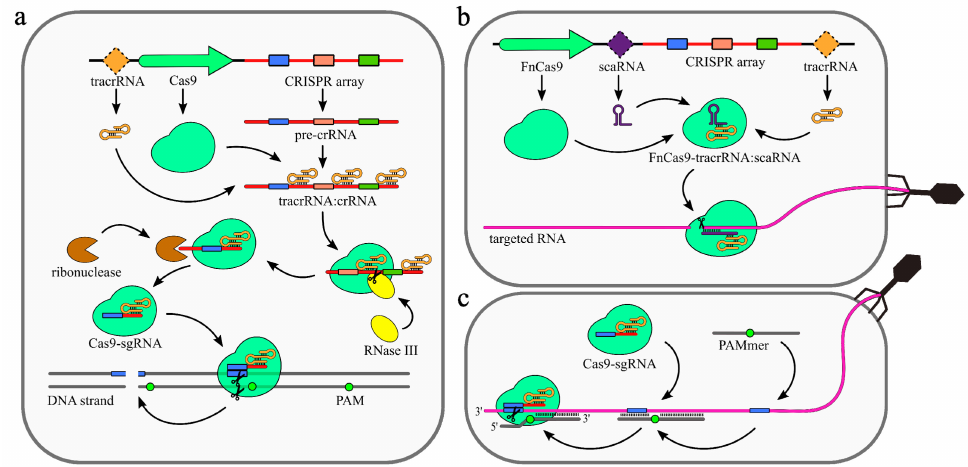
Figure 3. Mechanism of the CRISPR–Cas9 (type II) system. ( a ) DNA targeting CRISPR array transcription generates pre-crRNA. Maturation of the crRNAs is dependent on trans activating RNA (tracrRNA), which is partially complementary to the repeat sequences in the pre-crRNA resulting in tracrRNA / crRNA duplex formation. Those duplexes are bound and stabilized by Cas9 protein. Host RNase III is then recruited to cleave pre-crRNA into units containing single spacer sequences. Further trimming of the crRNAs is performed by unknown ribonuclease. The complex of Cas9 and single guide RNA (sgRNA: tracrRNA–crRNA) scans DNA until it finds a Protospacer-Associated Motif (PAM) sequence. The DNA strand is then unwound, allowing sgRNA for complementarity verification. Positive recognition results in cleavage of both DNA strands. ( b ) scaRNA-dependent RNA targeting was observed for Cas9 from Francisella novicida (FnCas9). Small CRISPR / Cas-associated RNA (scaRNA) hybridizes with tracrRNA to form heteroduplex that binds Cas9 protein. FnCas9–tracrRNA / scaRNA complex targets RNA partially complementary to scaRNA sequence. The precise mechanism of FnCas9 remains unclear. ( c ) PAM-presenting oligonucleotide (PAMer)-dependent RNA targeting Functional Cas9–sgRNA complex is able to target RNA in the presence of PAMmers–short DNA oligonucleotides containing PAM. When the PAMmer is bound to target RNA, the Cas9–sgRNA complex is able to recognize and cleave the RNA as long as complementarity between sgRNA and targeted RNA is